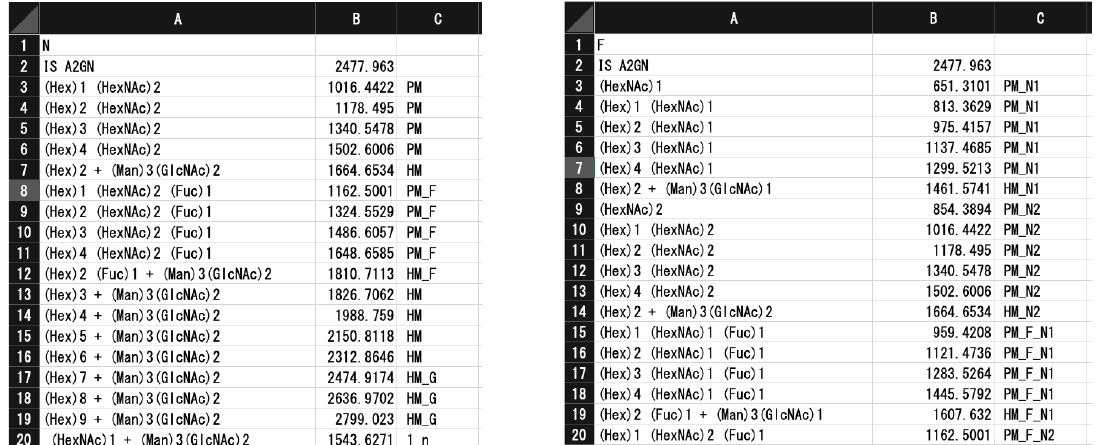
Figure 2. Examples of glycan lists ( N -glycans on the left, free N -glycans (FNGs) on the right) generated by TAG